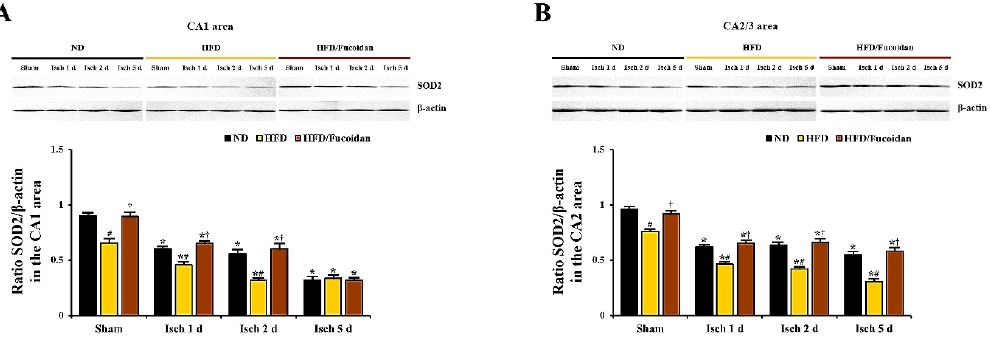
Figure 11. Western blot analysis of SOD2 in the CA1 ( A ) and CA2/3 ( B ) areas ( n = 7/group). Protein expression is normalized to β -actin. The bars indicate the means ± SEM. * P < 0.05 vs. each sham group, # P < 0.05 vs. ND-fed group, † P < 0.05 vs. HFD-fed group.